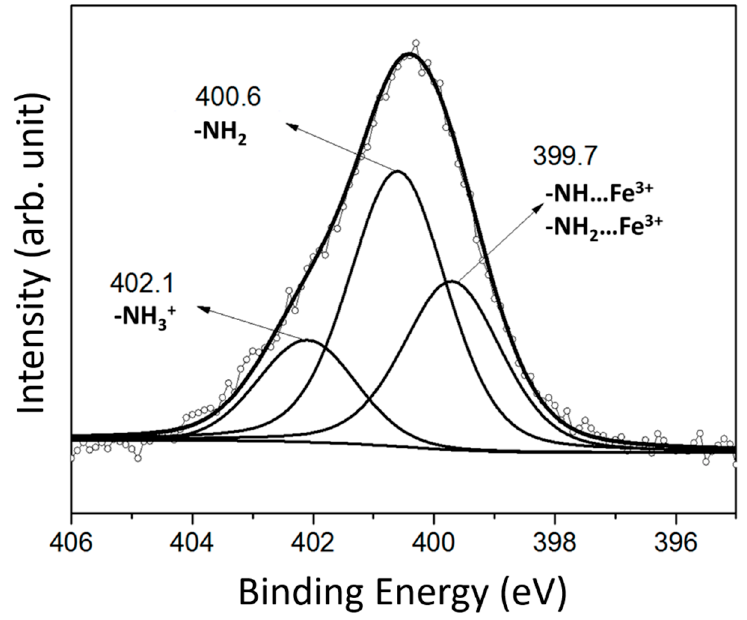
Figure 4. X-ray photoemission spectrum of the N1 s core level region of a 13-layer-thick DODA-clay- Fe/POSS hybrid film.